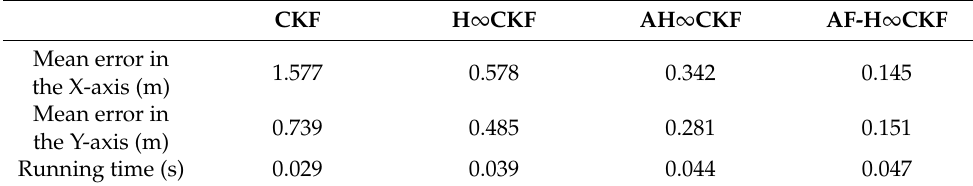
Table 2. Comparisons of the four